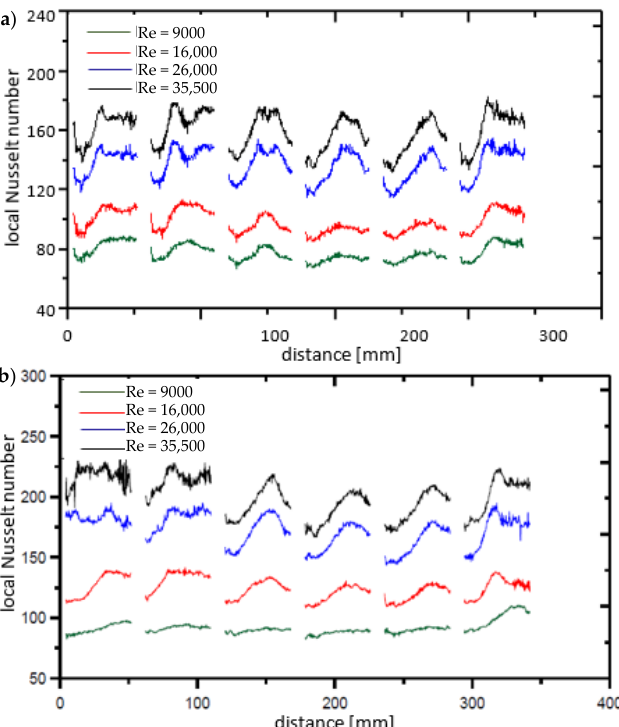
Figure 11. Local Nusselt numbers distributions for Re = 9,000; 16,000; 26,000 and 35,500 obtained by means of liquid crystal thermography (configuration_7): central zone ( a ) and wall zone ( b ).